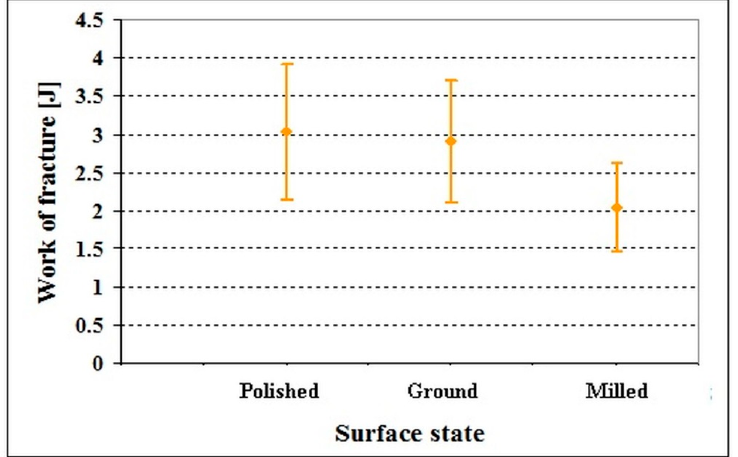
Figure 6. Work of fracture of specimens made of the Vanadis 6 steel with different surface finish. Adapted from the corresponding literature [45]. (Copyright, Materials Engineering/Materiálové inžinierstvo, 2011).